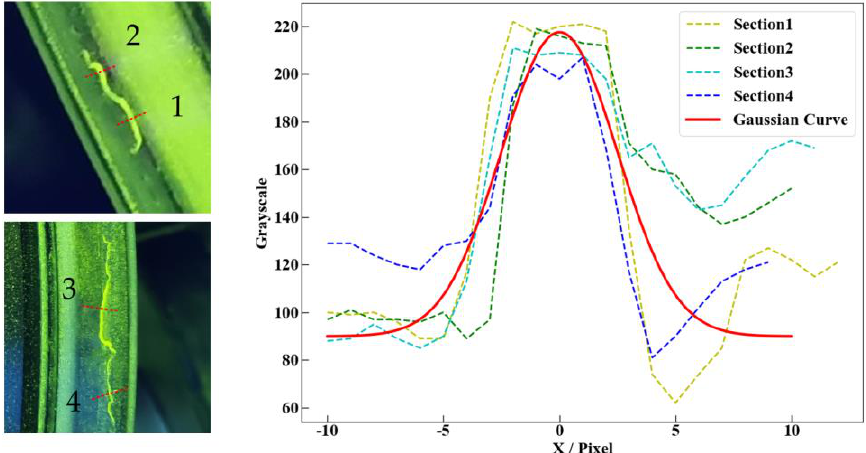
Figure 4. Structure of the sliding window. The sliding window traversed all pixels of the extracted centerline in inspection images, and the y-axis (vertical direction) of the window is rotated to coincide with the e2 direction (tangent direction of the extracted centerline). Then, we compare all pixel values in the mask region and the corresponding values in the sliding window before obtaining their cosine similarity. The Gaussian similarity of the regions is measured using cosine similarity by calculating the cosine value of the angle between two vectors. The closer the cosine value is to 1, the closer the angle  is to 0, and the more similar the two vectors are. The cosine similarity